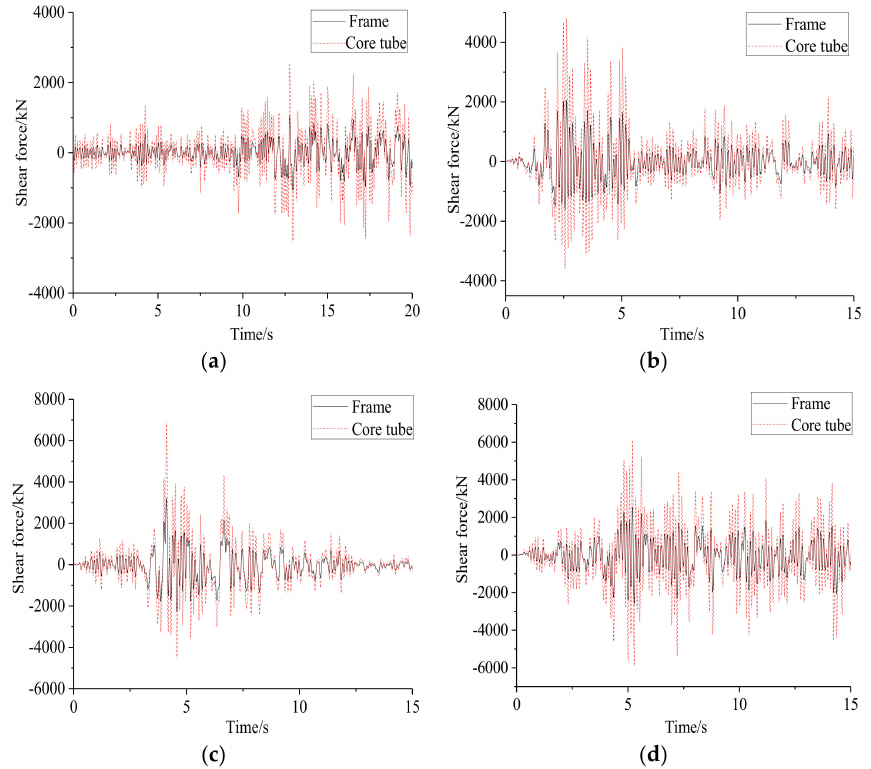
Figure 19. Shear distribution of bottom under different seismic wave in case 1: ( a ) HOLLYWOOD, ( b ) ELCENTRO, ( c ) NRIGDE and ( d ) Artificial wave.